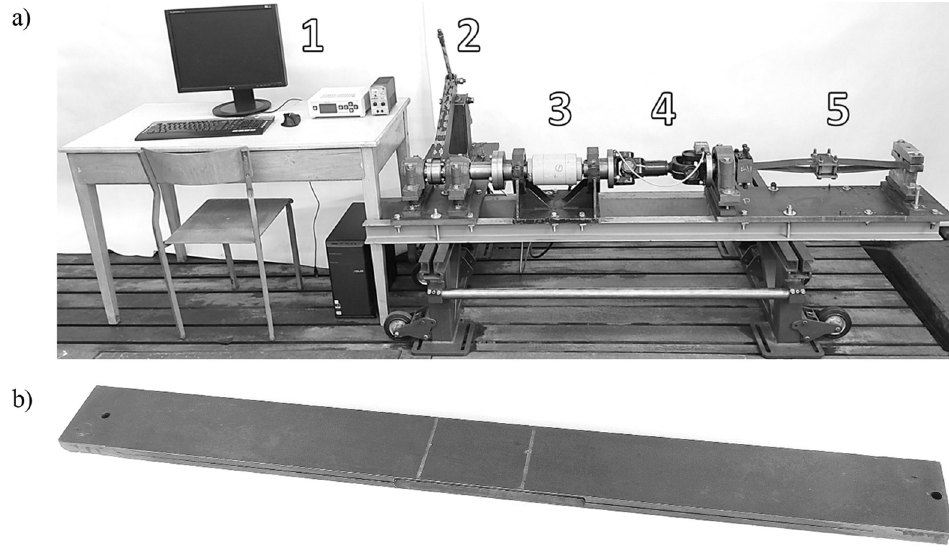
Figure 5. ( a ) Test stand. ( b ) Test set 6 × 60.